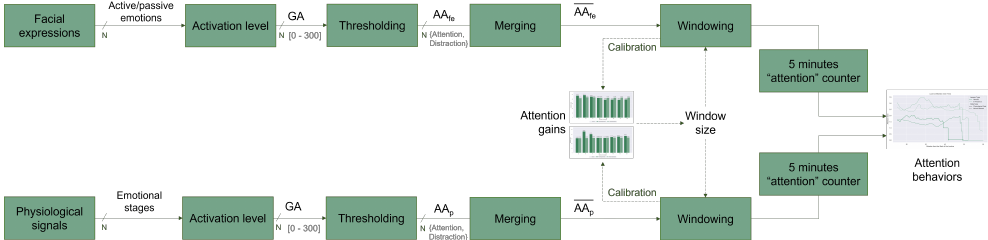
Figure 2. The workflow of the proposed analysis approach. The dashed arrows represent the WS calibration